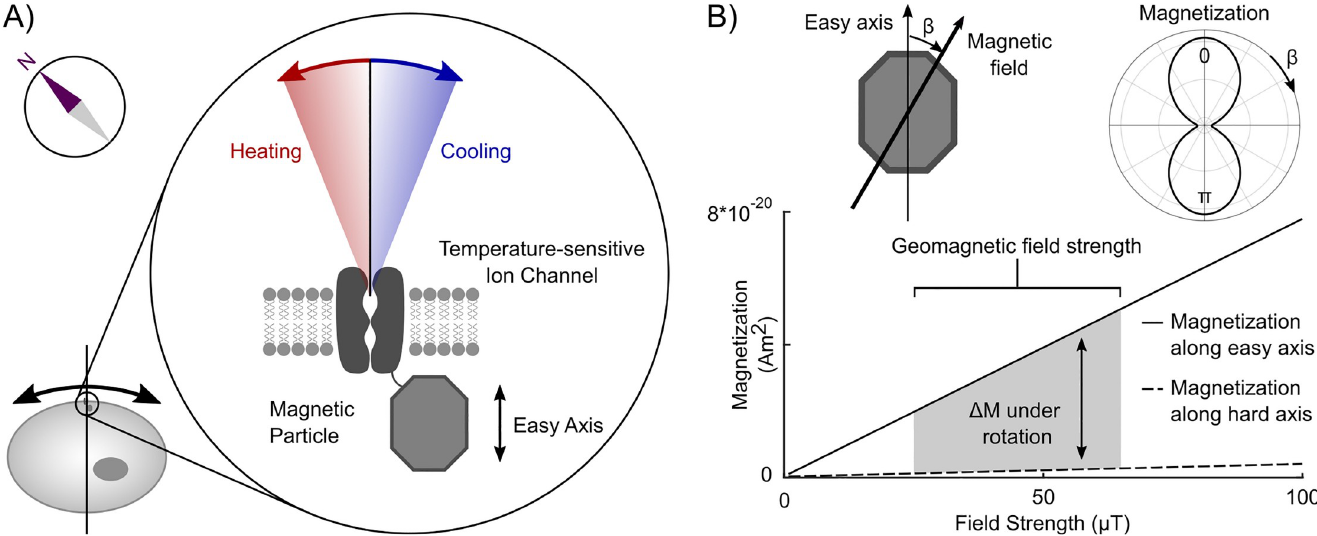
Fig 1. Concept for how the rotating magnetocaloric effect could provide a mechanism for natural magnetosensation. (A) Schematic of a RME-receptor: a magnetically anisotropic particle is bound to a temperature sensitive ion channel. This particle will release or absorb heat energy under rotation in a magnetic field, and this energy could influence the gating of the associated channel. (B) The magnetization of a magnetic nanoparticle is a function of the angle between the easy axis of the particle and the direction of the applied field as shown in the radar plot. Thus rotation will cause the particle magnetization to change, despite no change in the strength of the applied field. For most materials, the easy and hard axis magnetizations are approximately linear for geomagnetic field amplitudes (25-65 μ T). As a result, we can calculate the maximum change in magnetization Δ M as this difference between the magnetization when the field is along the easy axis (solid line) and hard axis (dotted line). These values are calculated based on 10 nm radius magnetite particles. The gray shaded region shows Δ M * 0.4 × 10 − 20 Am 2 for rotation in an Earth-strength magnetic field.